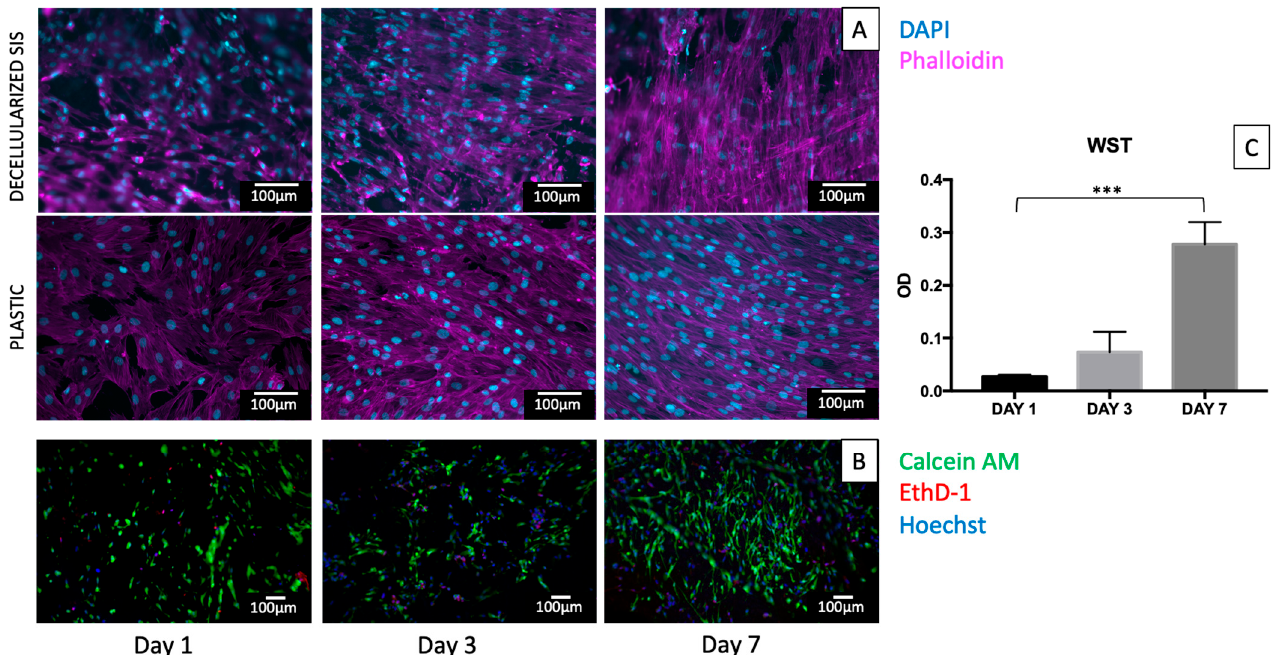
Figure 5. Cell proliferation on decellularized SIS. Patches were seeded with 20,000 cells/cm 2 and stained with phalloidin (magenta) and DAPI (cyan) ( A , first row). Control group of cells seeded on plastic is reported in the second row ( A ). Throughout the time course, a progressive increase in cell number was found with a concurrent organization of cells along the principal directions of collagen fibres (here, z-stacks are reported of epifluorescence images). Live/dead staining on seeded SIS at days 1, 3, and 7 ( B ). Nuclei were stained with Hoechst in blue, live cells were stained green with calcein AM. and dead cells were stained in red by ethidium homodimer-1. For all the time points, few dead cells were detected, while an increase in the number of live cells was evident over time, showing also an increase in cell alignment along the SIS fibres. Optical density (OD) on tissue seeded with an initial number of 20,000 cells/cm 2 is reported ( C ), showing a significant difference between day 1 and day 7. Dunnett’s multiple comparisons test was performed (n = 3), comparing day 3 and day 7 to day 1 (control group). Data show mean± SD, *** p < 0.001.